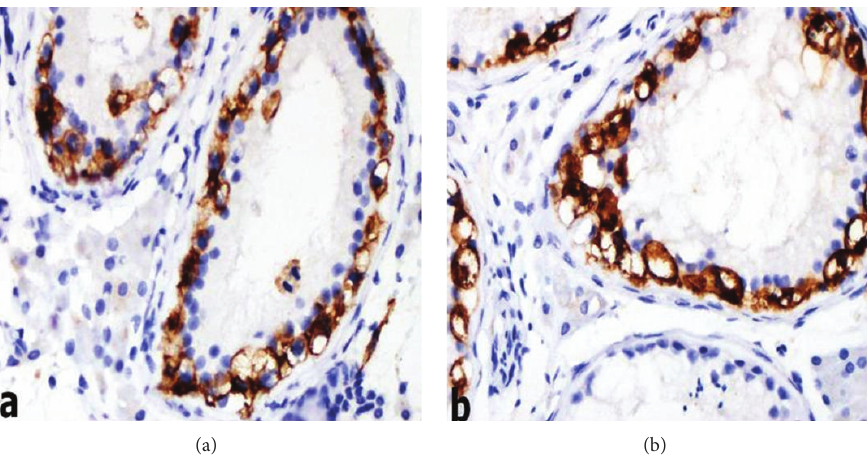
Figure 5: Intratubular neoplastic germ cells show up positive with antibodies of CD117 (a) and PLAP (b) in immunohistochemical staining (immunoperoxidase;